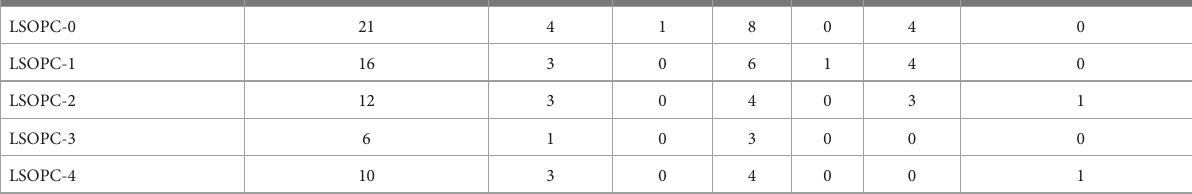
TABLE 3 Flavor substances analysis by